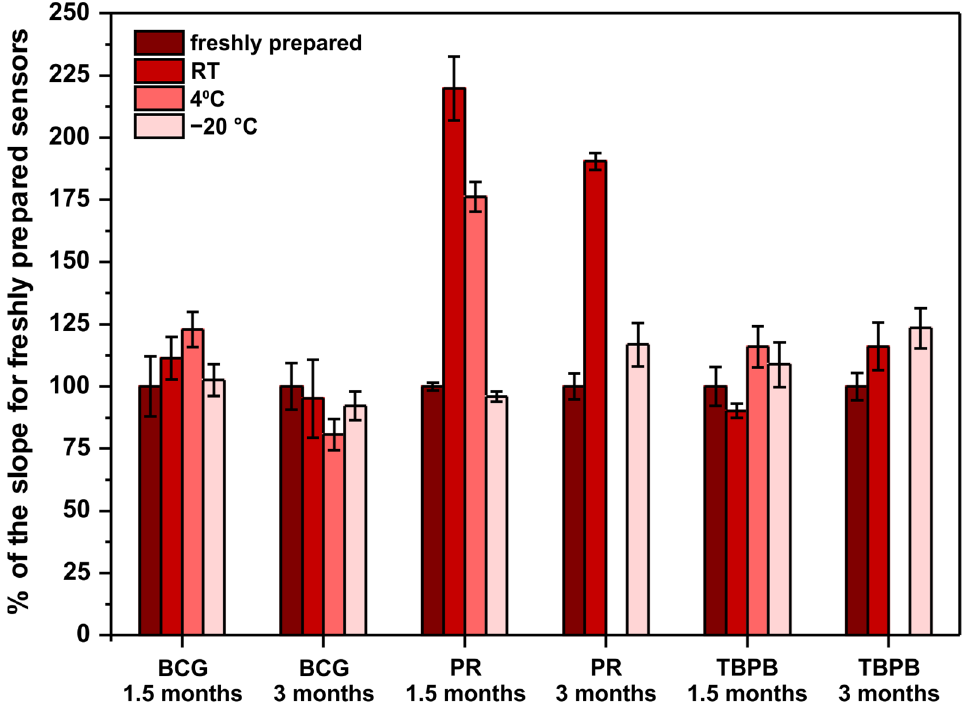
Figure 3. Sensors’ long-term stability study. The parameter on ordinate is the percent of the obtained calibration curve’s slope in comparison to the slope for freshly prepared sensors—100% would mean that the sensors do not change their sensitivity when subjected to storage. Note that there are no bars for PR and TBPB stored in 4 °C for 3 months due to sensors’ destruction by moisture in the fridge.